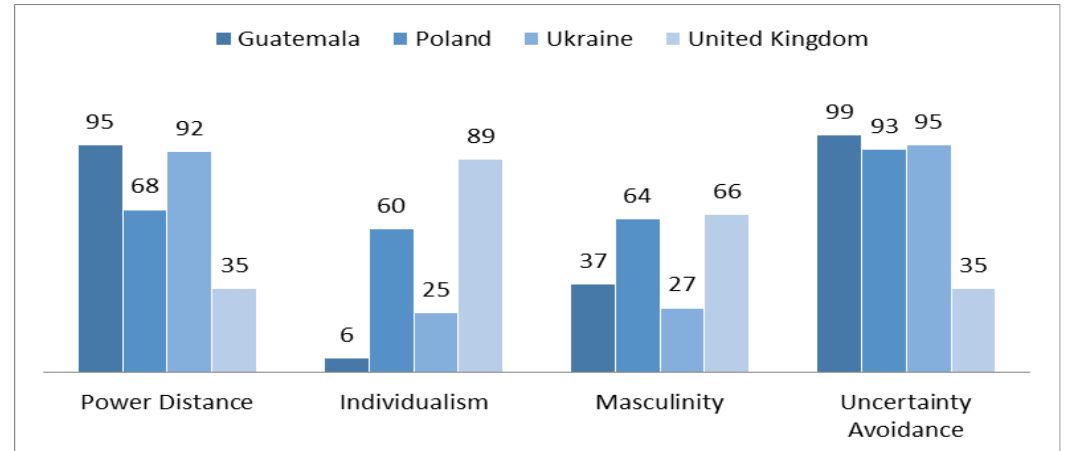
Figure 8. Geert Hofstede cultural dimensions for the countries